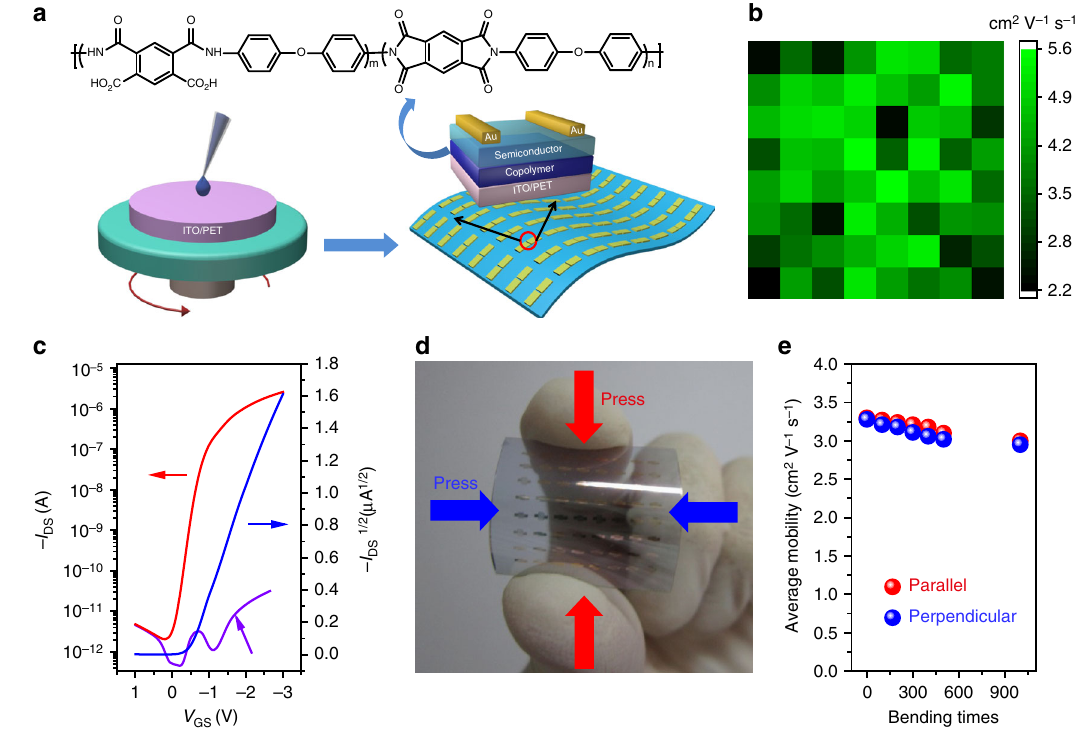
Fig. 4 Device structure and performance. a The preparation process for large-area fl exible OTFT arrays. b Distribution of device mobility. c Typical transfer curve of the OTFT with 50 nm pentacene and a channel dimension of W = 240 μ m, L = 30 μ m. The gate current as a function of gate-source voltage is shown in purple. d A photograph of fl exible devices for the test of bending effect. e Plots of mobility versus bending times on PET substrate based on copolymer insulating layers